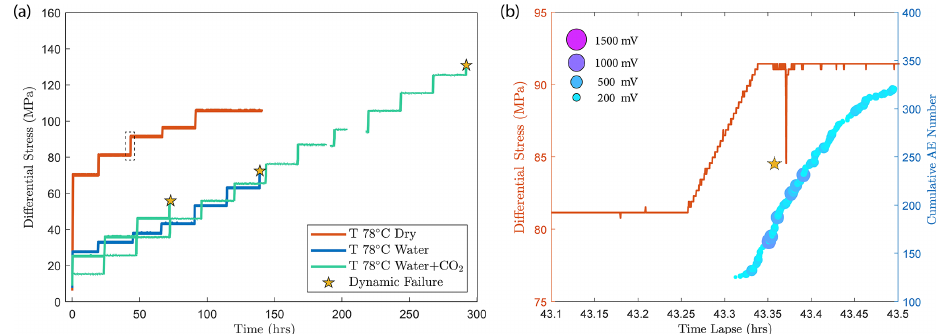
Figure A2. (a) Differential stress vs. time plot of experiments conducted at temperature of 78 ◦ C. The dry experiment (red) was ceased before dynamic failure occurred in the sample. (b) A temporary stress drop was observed (highlighted by the dashed rectangle in panel a ) during the primary creep of the dry experiment at a creep stress of ∼ 90MPa accompanied by the occurrence of high-amplitude AEs.